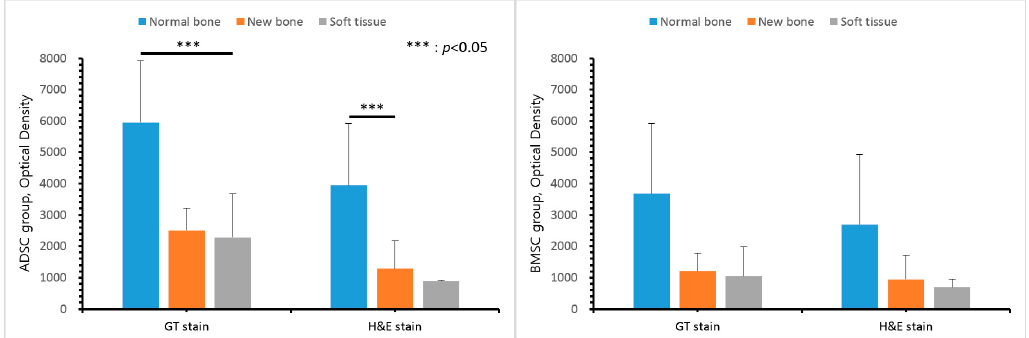
Figure 9. Optical density of Hematoxylin and Eosin stain (H&E) and Goldner’s trichrome (GT) staining.